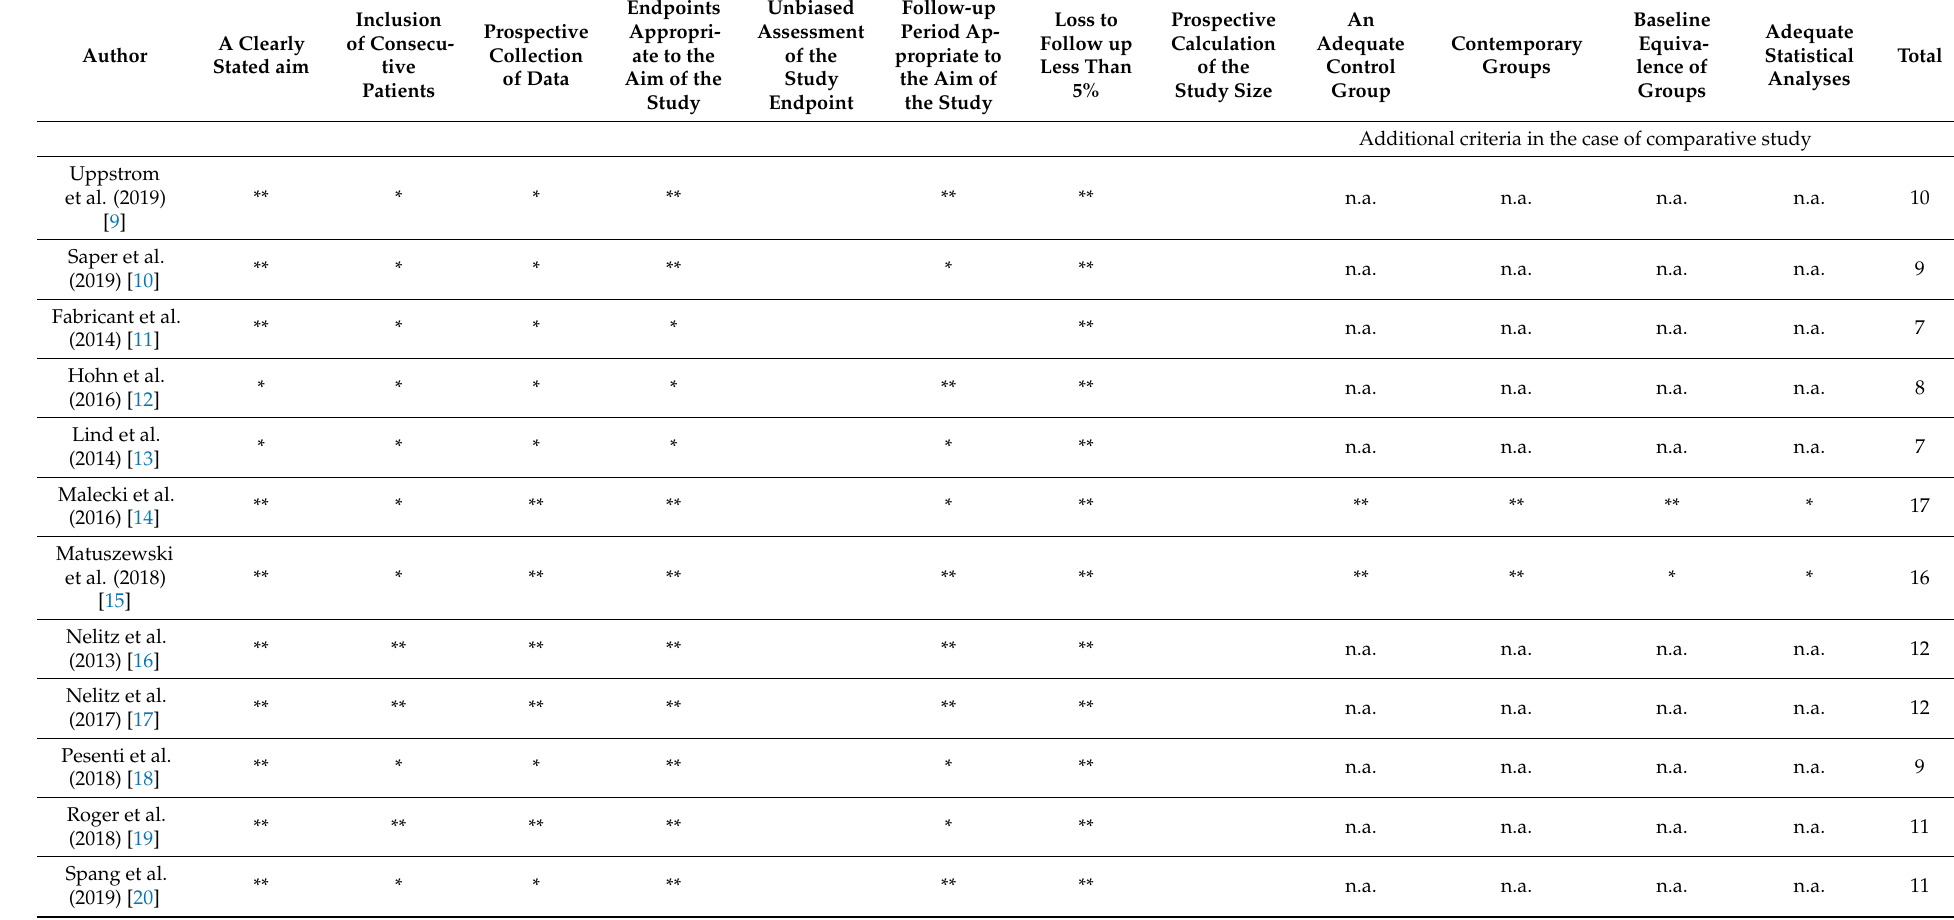
Table 2. MINORS score for the studies included in the